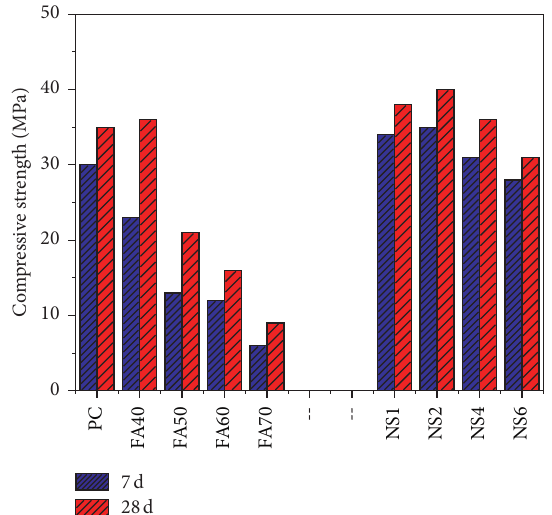
Figure 11: Compressive strength of mortars containing NS and FA [73].